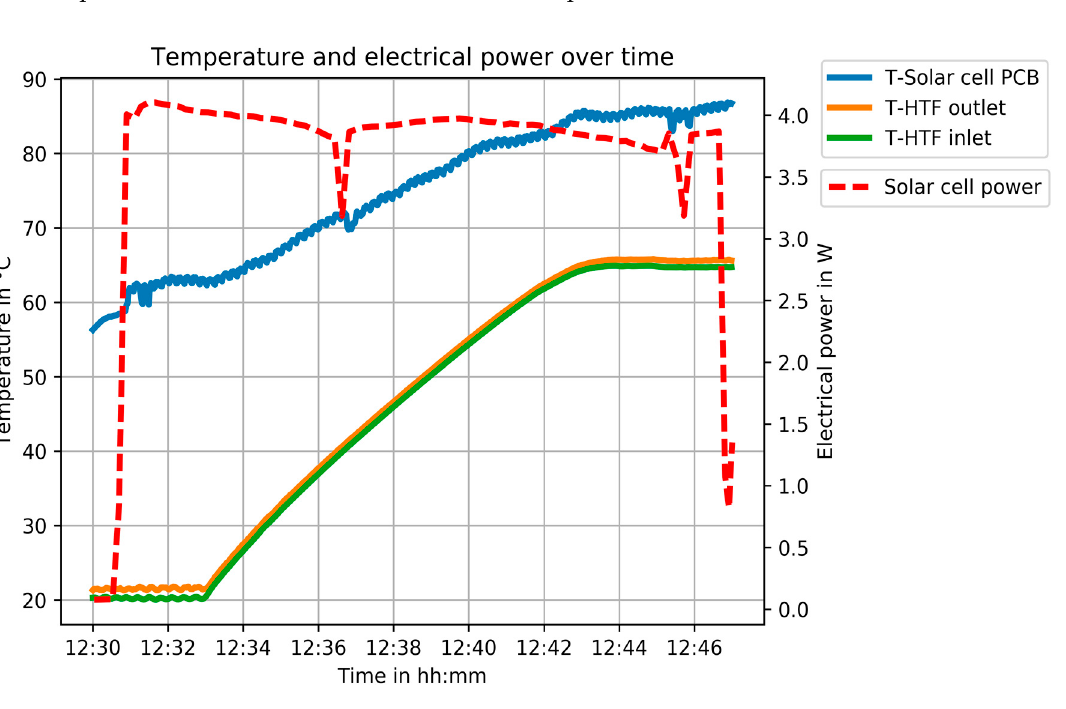
Figure 19. The temperatures (continuous lines) and the power of the solar cell (MPP; dashed line) shown over time. Due to the noon time there is less sun movement. This was used to change the temperature under similar conditions. It can be seen that the temperature difference between cell and heat transfer fluid decreases with increasing water temperature and at the same time the solar cell output decreases. At 12:36:40 and 12:45:40 the tracking system was manually readjusted. The maximum electrical power of the 10 × 10 mm 2 solar cell reaches 4.1 W (see Figure 20). The measurement started with a HTF temperature of 20 °C, followed by a transition to 65 °C, which was kept constant afterwards. It can be seen that the temperature differences between HTF (T-HTF outlet) and solar cell (T-Solar cell PCB) are larger (in comparison to the last test in Section 3.2), due to the more precise alignment of the line focus and the higher irradiance. Figure 20. IV-curve and electrical power of the solar cell measured at 12 h:31 min:36 s (focus on the center of the cell). The maximum power point (MPP) of 4.1 W at 2.6 V can be seen.